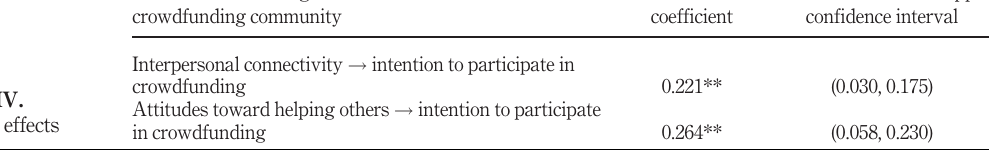
Indirect effects through Social Identification with crowdfunding